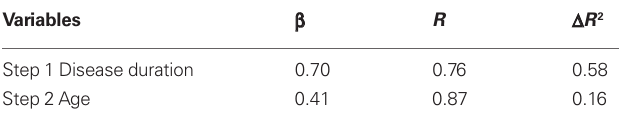
Table 3 | linear stepwise regression on ∆ rPe oN–oFF in the 90/10 condition as a function of disease duration and